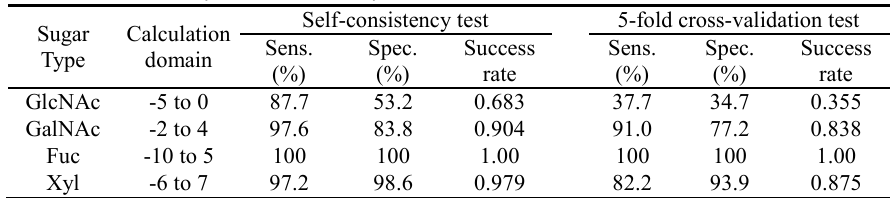
Table 2. Accuracies of sugar type discrimination in O -glycosylation by self-consistency test and 5-fold cross-validation test